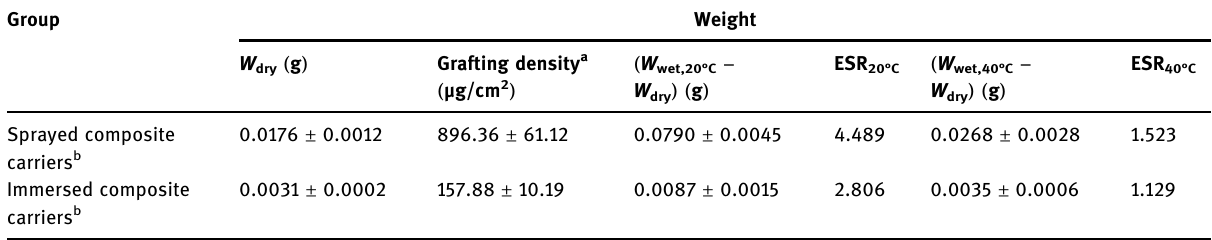
Table 1: Grafting density and equilibrium swelling ratio of sprayed and immersed composite carriers Group Weight W ( g ) Grafting density dry